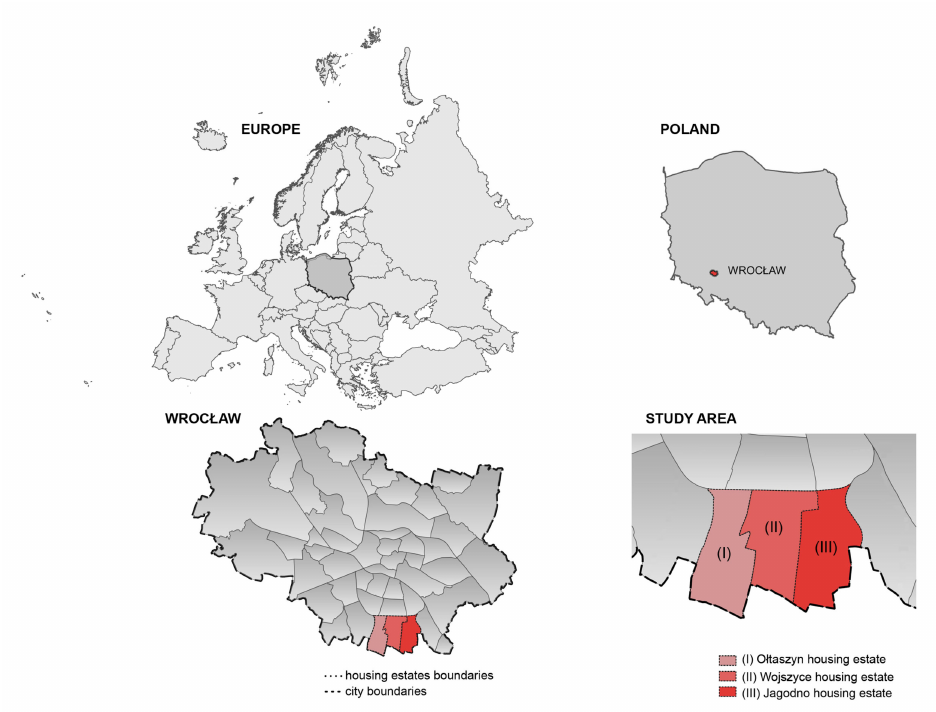
Figure 1. Study area.